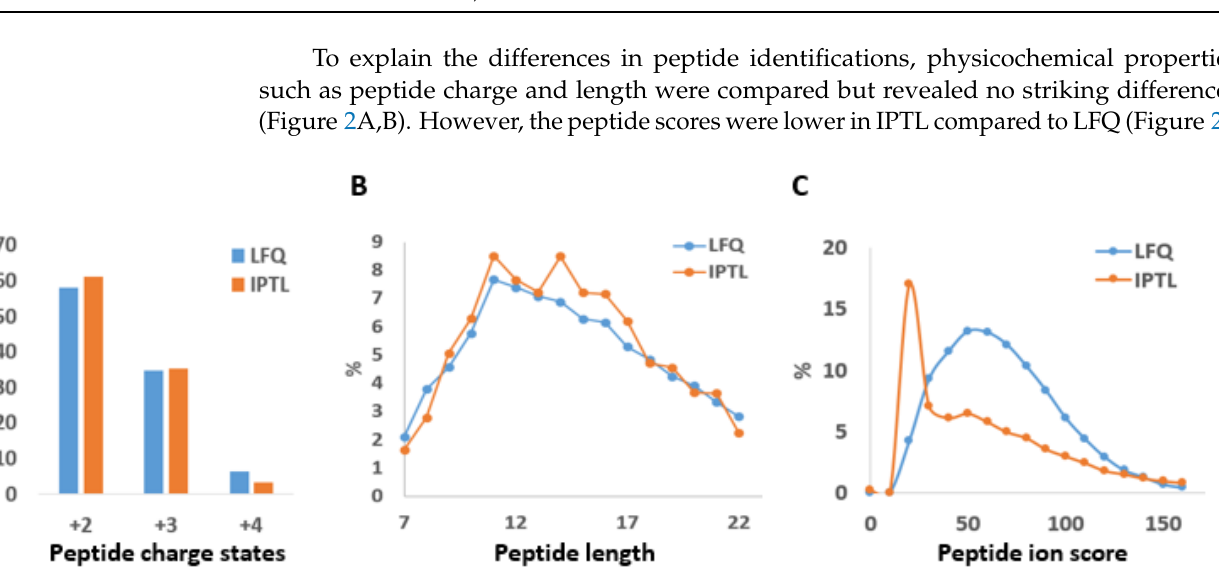
Figure 2. Characteristics of quantified peptides using LFQ and IPTL. ( A ) The peptide counts with charges of 2+ to 4+ is shown, ( B ) the peptide length are compared, and ( C ) the distribution of the peptide ion scores from Mascot is displayed.